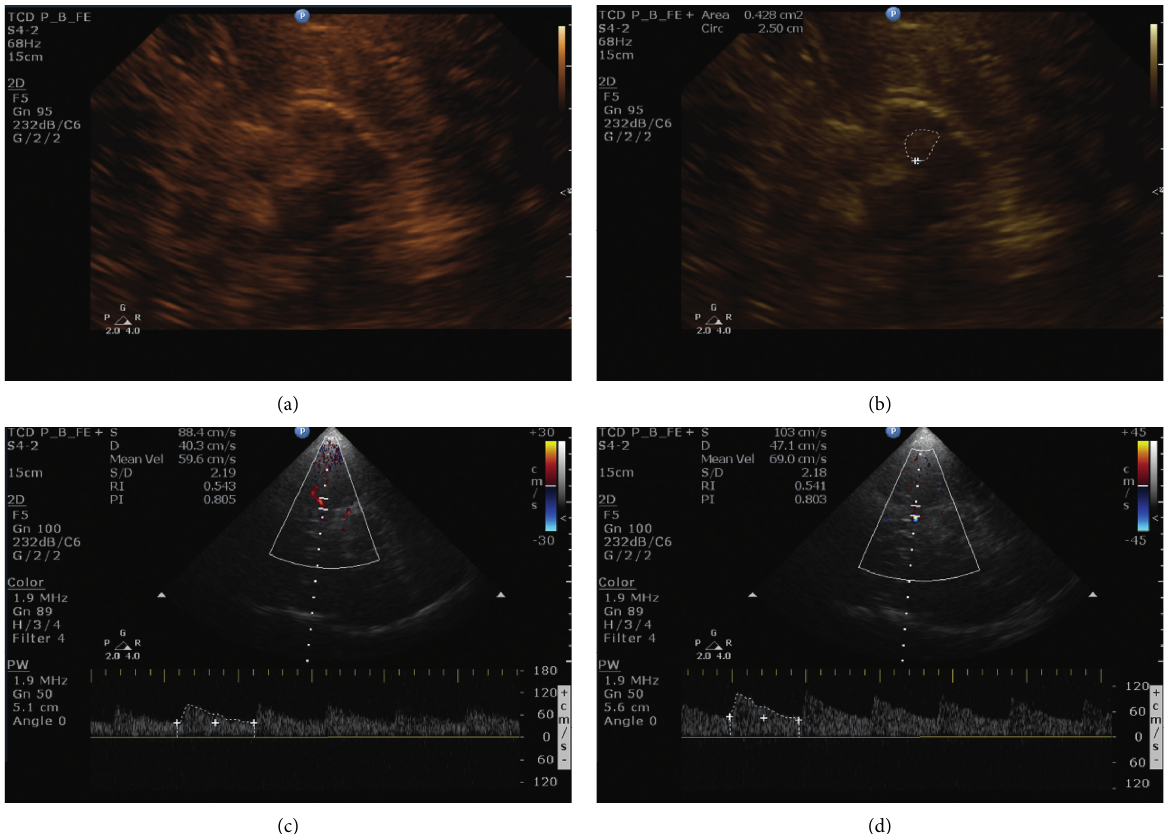
Figure 1: TCCS showing image of the midbrain in (a) and increased SN echogenicity areas ( � hyperechogenicity) at the anatomical site of SN in a patient with Parkinson’s disease (the area circled in (b)). TCCS examination of intracranial vascular vascularity provided data on the middle cerebral artery (MCA) mean flow velocity (Vm), pulsatility index (PI), and resistance index (RI) of the MCA during rest (c) and after apnea test (“breath-holding test”)